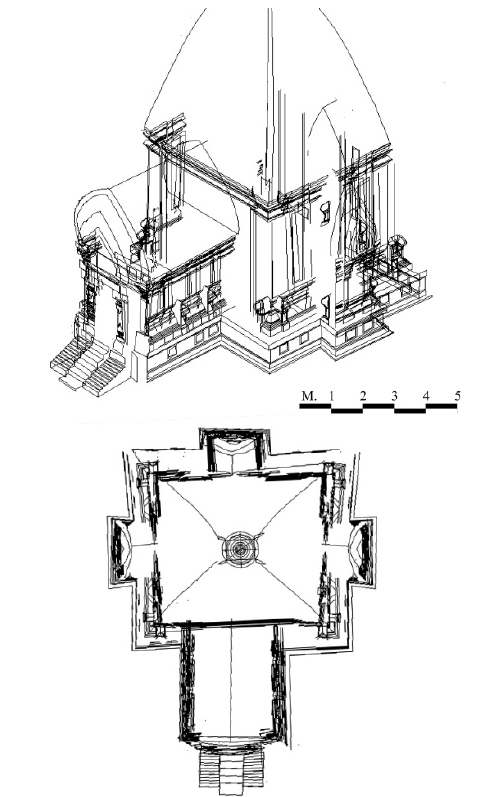
Figure 12. Po Nagar axonometric view and plan